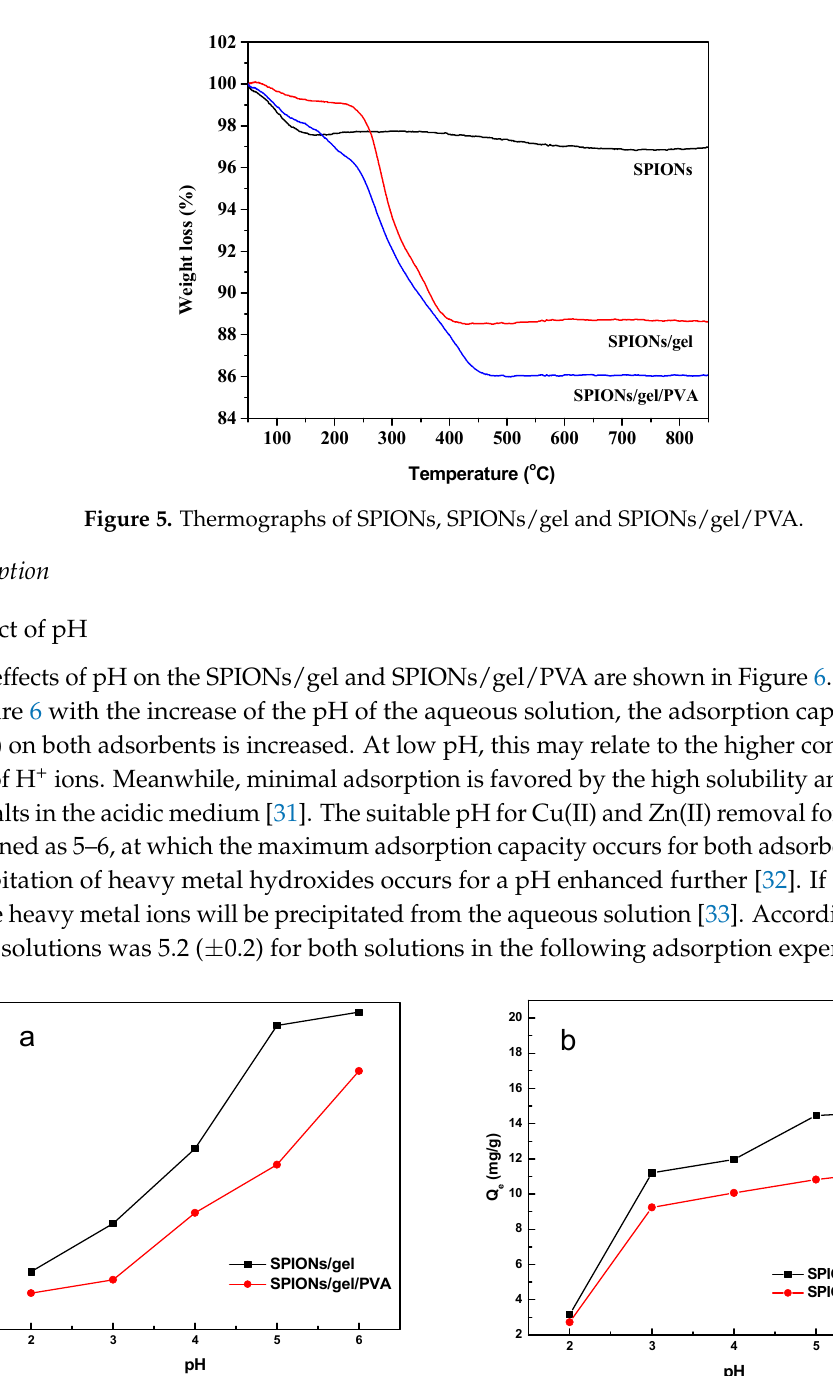
Figure 6. Effect of pH on Cu(II) ( a ) and Zn(II) ( b ) ions adsorption by SPIONs/gel and SPIONs/gel/PVA.